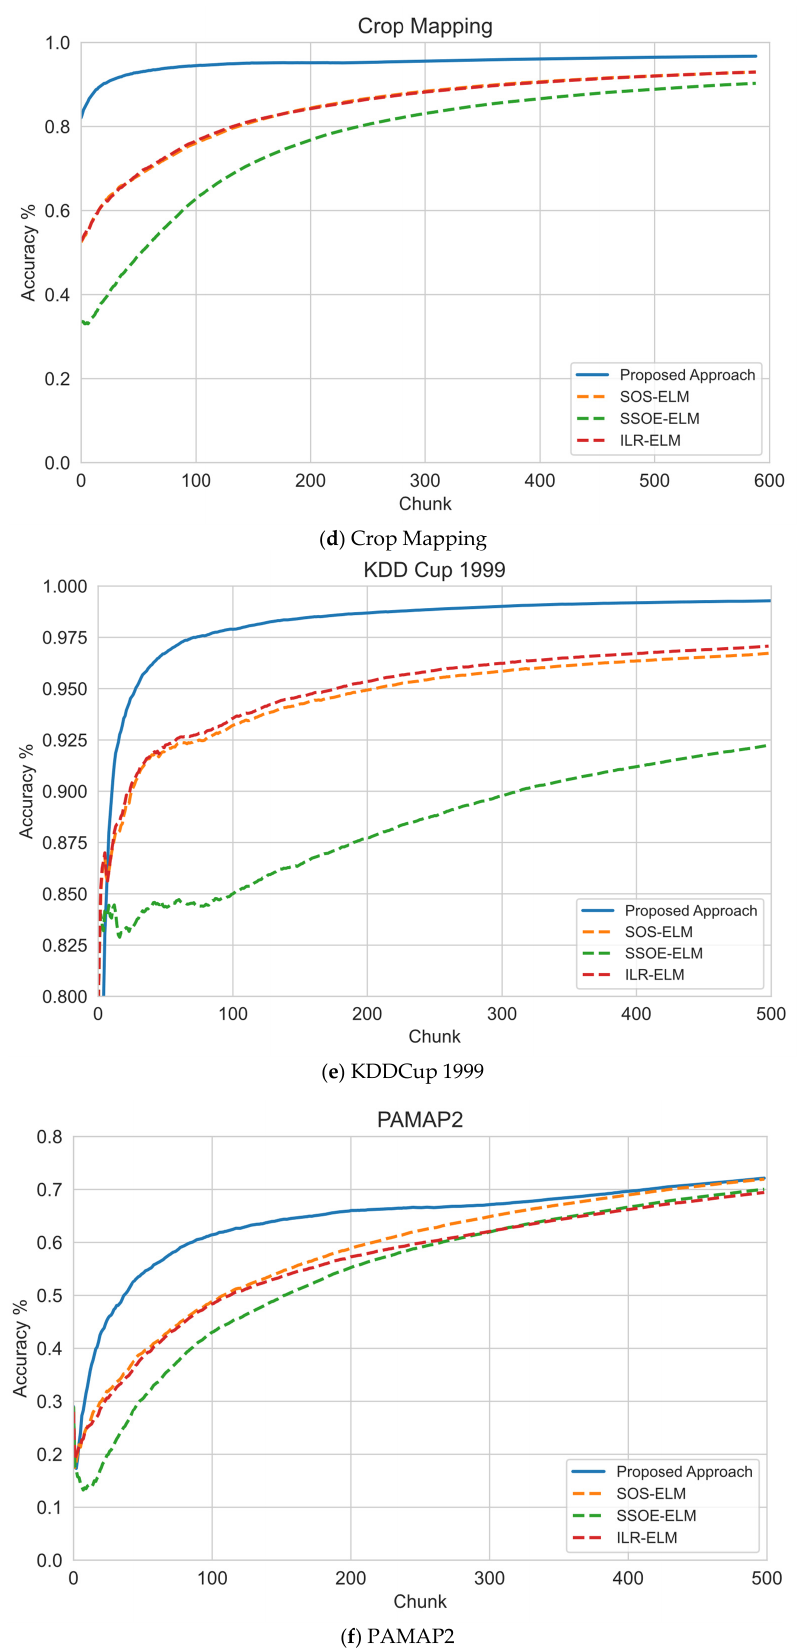
Figure 3. Sequential learning evaluation of this approach versus default RBF kernel hyperparame- ters for other approaches: ( a ) sensorless drive data set showed this approach performed compara- bly to other approaches; ( b ) magic gamma data set showed this approach learned faster than other approaches; ( c ) HAR showed this approach significantly learned faster than other approaches as it was a high-dimensional data set; ( d ) crop mapping, which was also a high-dimensional data set, also suggested that this approach can perform well on a high-dimensional data set; ( e ) on imbal- anced data set, the KDDCup1999 data set showed that this approach can learn faster than other approaches; ( f ) on PAMAP2 data set, this approach learned faster than other approaches but con- verged to the same accuracy. We then compared this proposed approach against other manifold regularization ap- proaches with the optimal RBF kernel width parameter, as shown in Table 2. This was to investigate if the proposed prototype regularized manifold regularization method could perform as well as other approaches when the best width parameter was selected to learn from a stream of unlabeled and with few labeled data. The result is presented in Figure 4a–f.